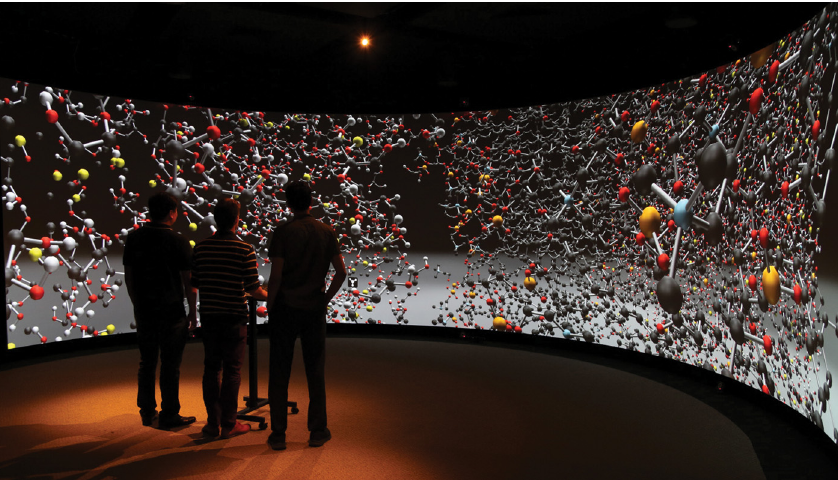
Figure 6: MDV running on the HIVE Cylinder